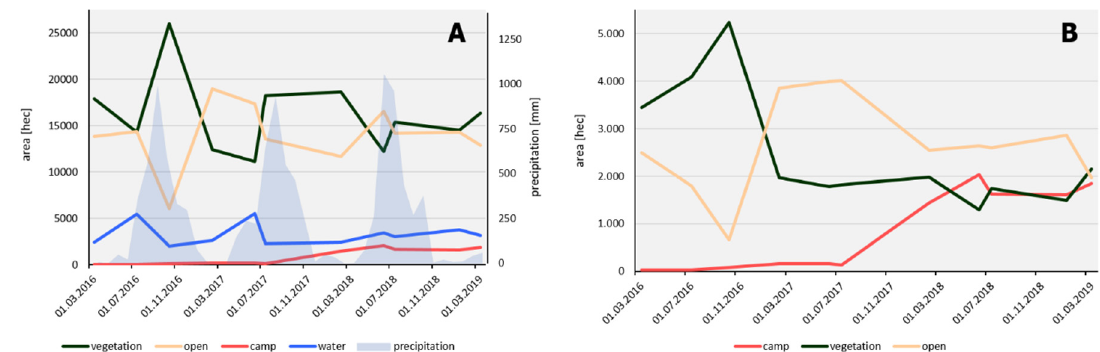
Figure 5. Land cover in hectares of the land cover classes vegetation, open, water, and camp. ( A ) full study area (including precipitation); ( B ) 2 km bu ff er around the camp (as illustrated by the dashed gray line in Figure 3D).